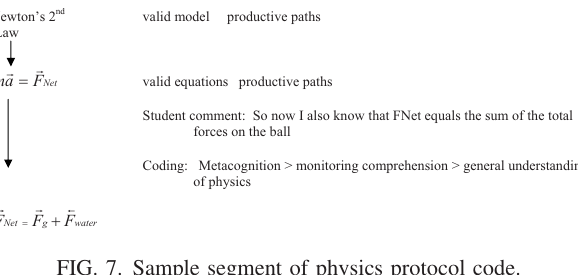
FIG. 7. Sample segment of physics